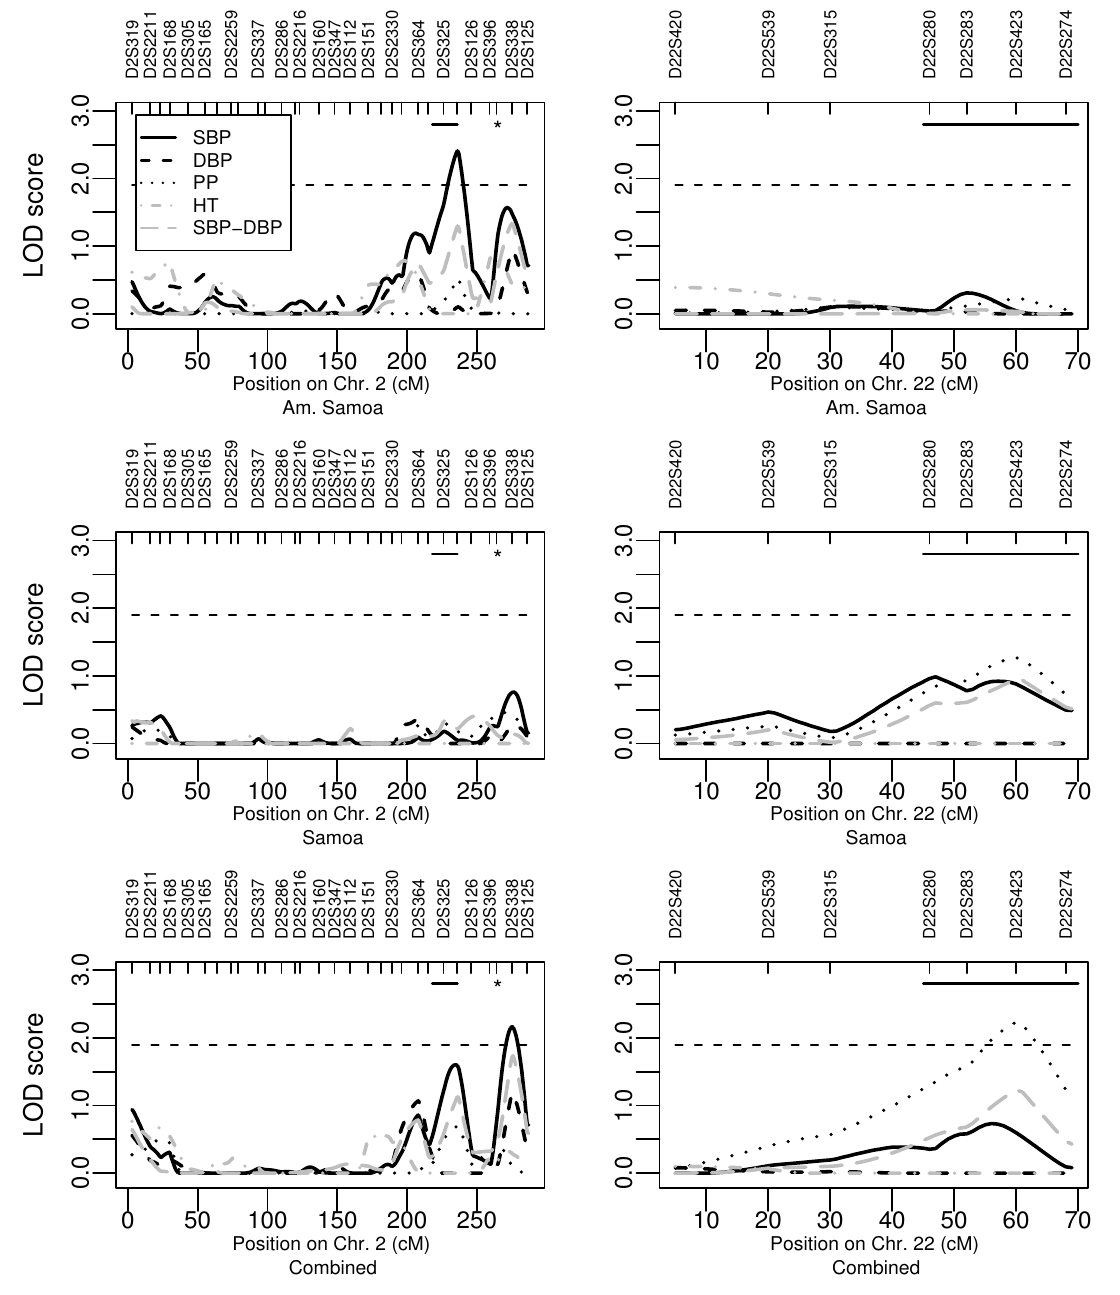
Figure 1 Linkage findings for blood pressure related traits on chromosome 2 and 22 . LOD score detected on chromosome 2 (left column) and on chromosome 22 (right column) in the three study samples from the Samoan islands. The LOD score for the bivariate trait SBP-DBP was converted to 1 degree of freedom, which makes it comparable to a univariate LOD score. For chromosome 2 the approximate region where linkage with SBP previously was detected is indicated with a black horizontal line and the region where association previously was detected is indicated with an asterisk (*). For chromosome 22 the approximate region for a susceptibility locus for PP previously reported by a meta-analysis is indicated with a black horizontal